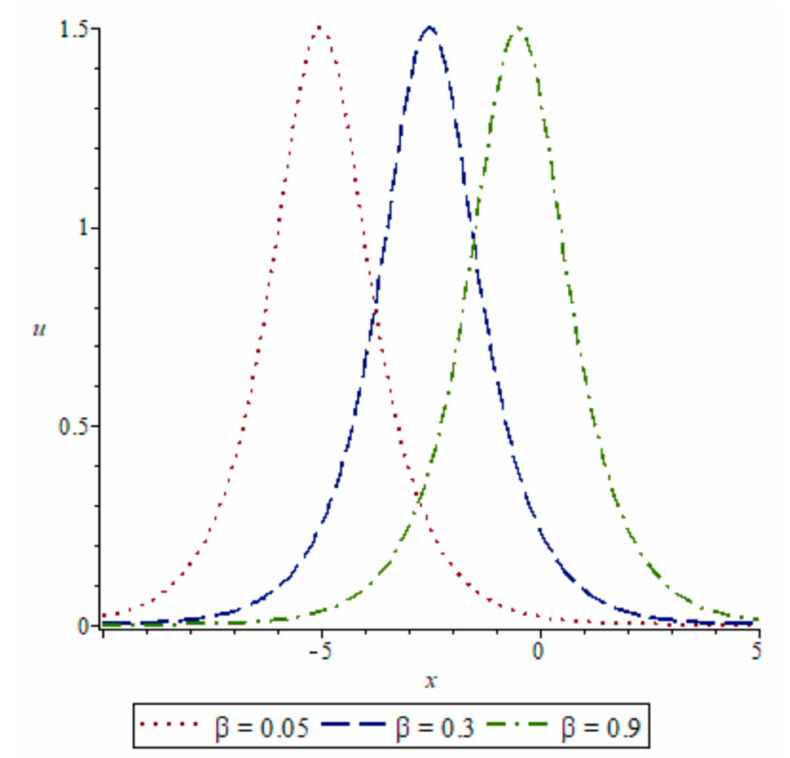
Figure 4. Locations of the solutions with different β